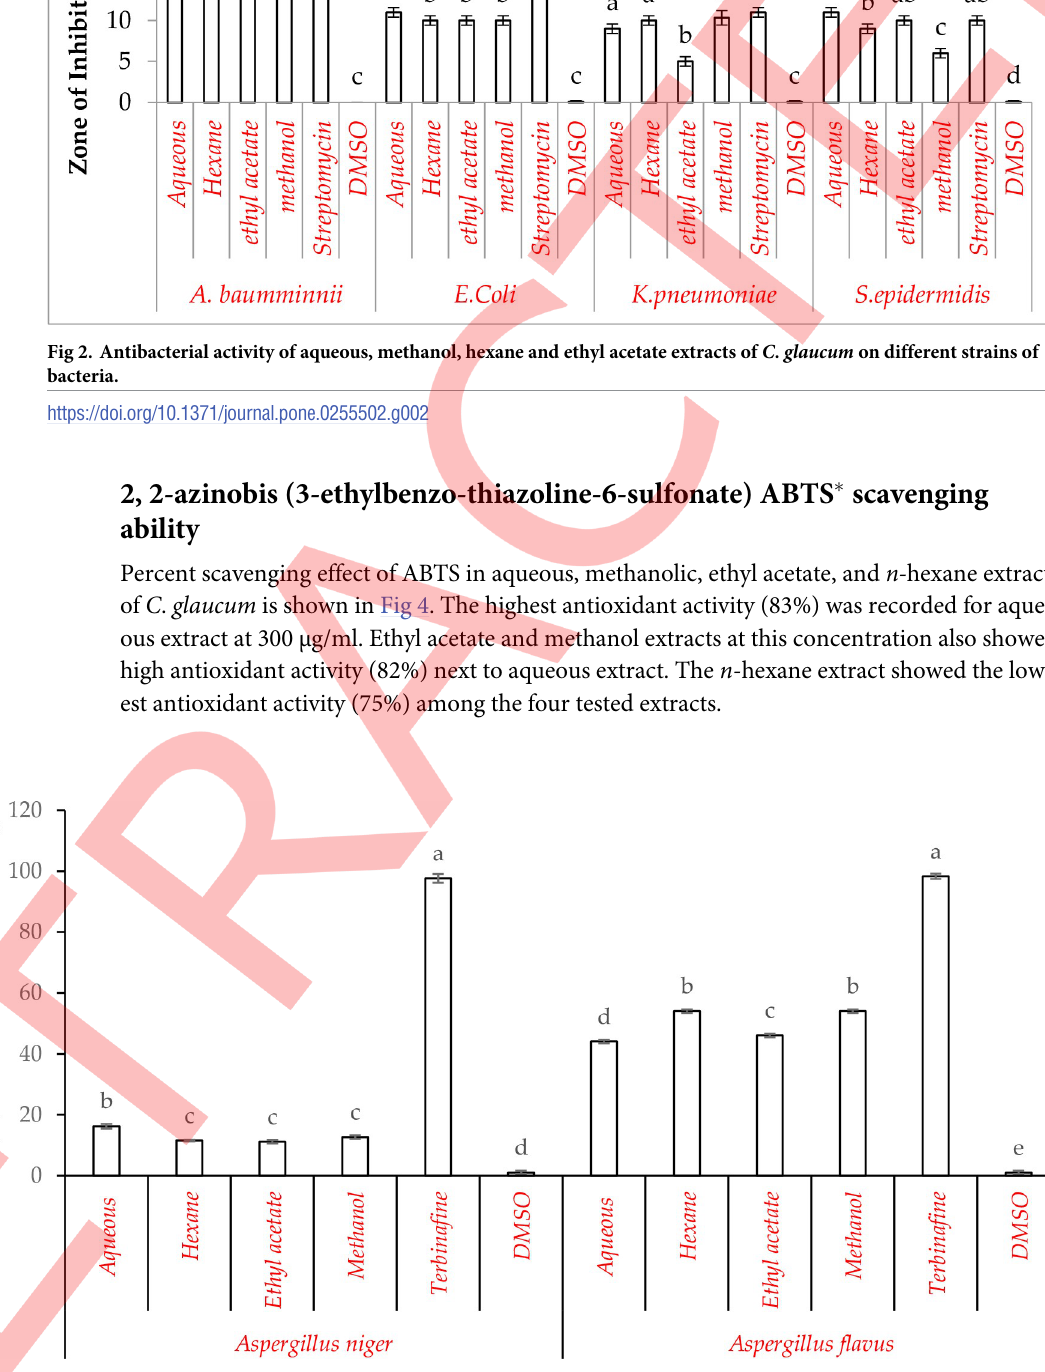
Fig 3. Antifungal activity of aqueous, methanol, hexane and ethyl acetate extracts of C . glaucum on two different strains of fungi.